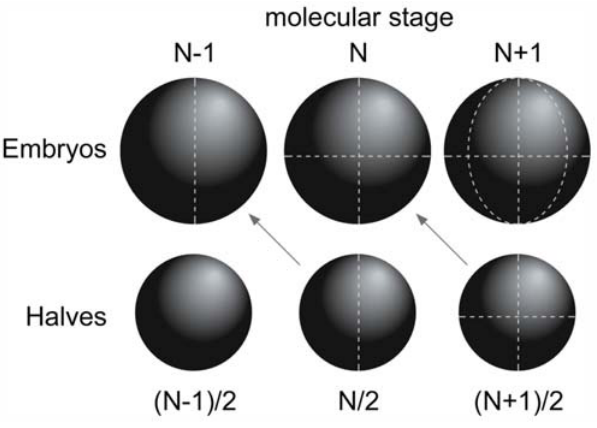
Figure 7. The spatial organization of cells in embryo halves corresponds to the one found in embryos of the preceding molecular stage. A half embryo at the molecular stage N (embryo N/ 2) will have a cellular 3D organization similar to the one observed in an embryo at the molecular stage N-1.